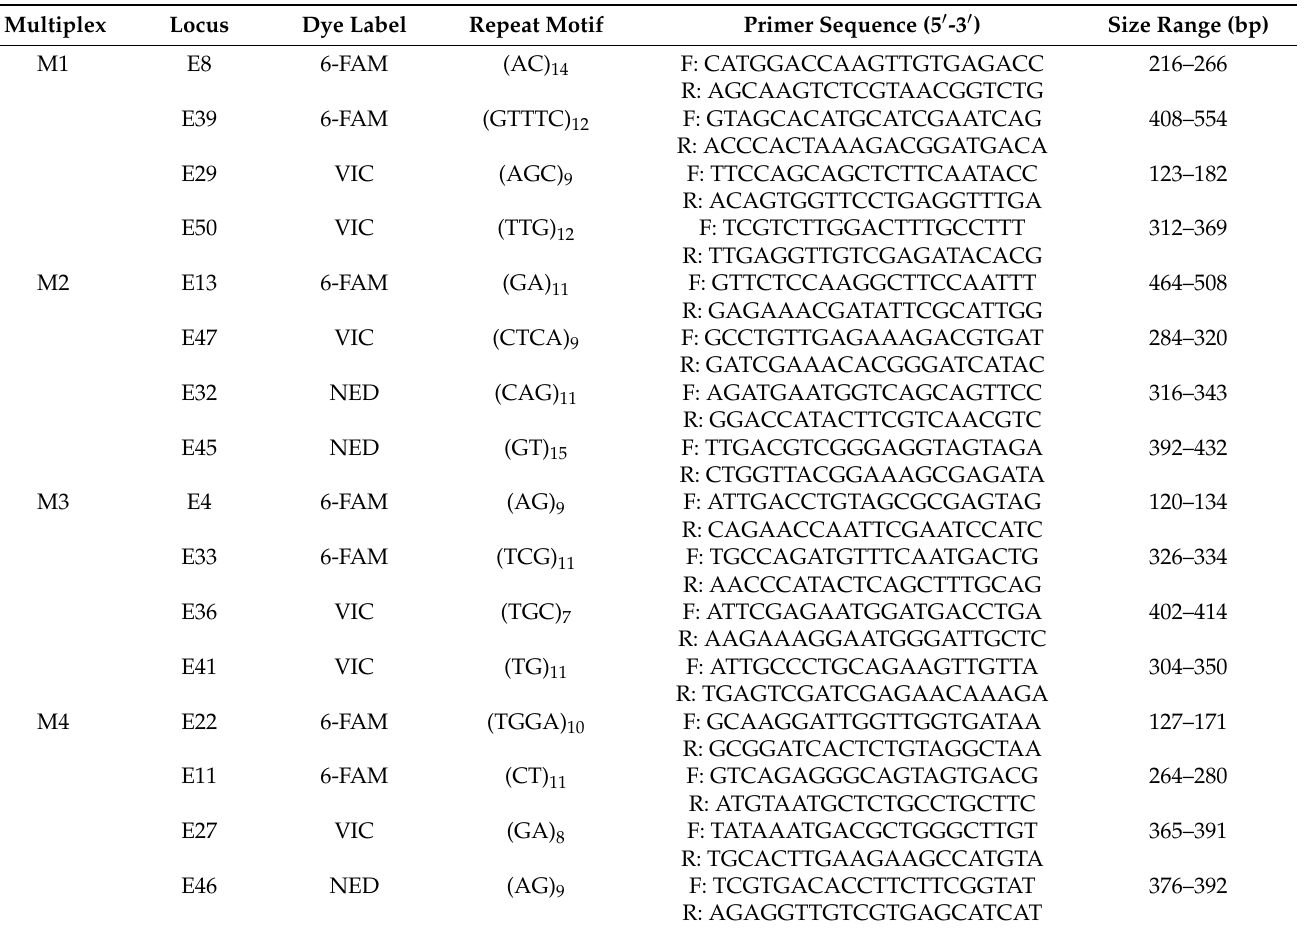
Table 2. Microsatellite loci from Epichloë spp. with repeat motifs, primer sequences and size ranges used in four fluorescent labelled multiplexes